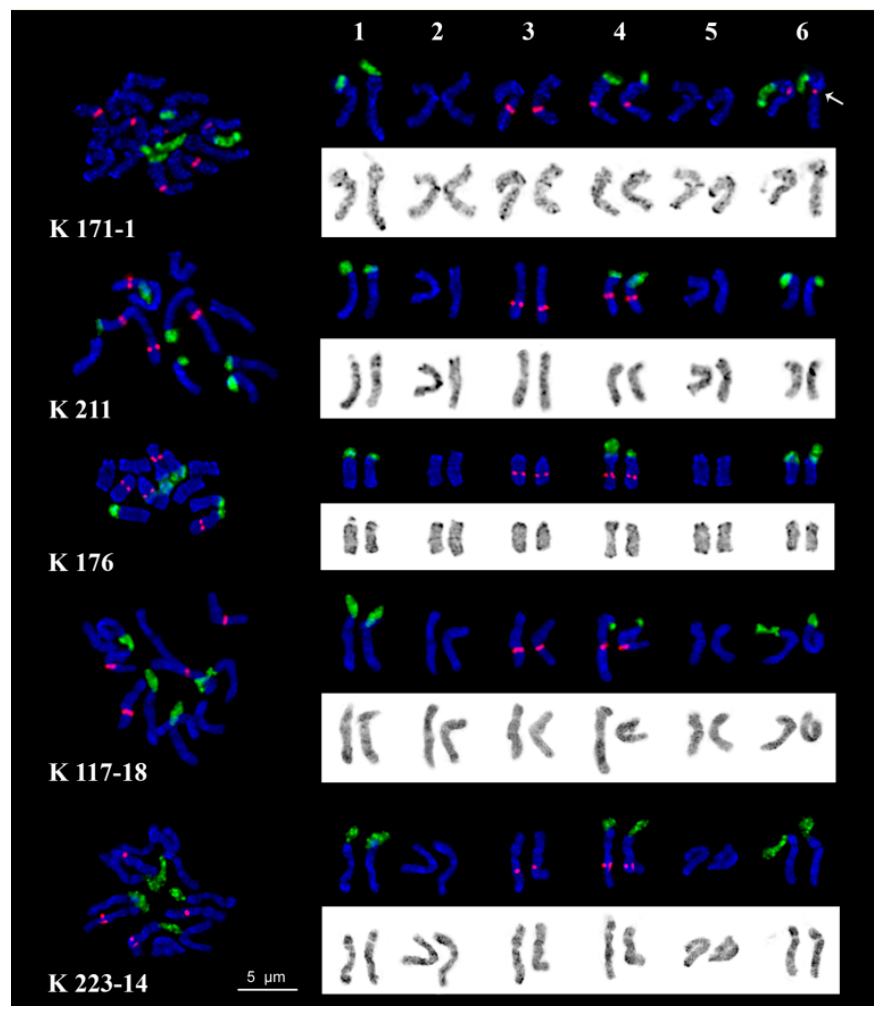
Figure 5. Karyotypes of the studied Chelidonium majus plants. Metaphase spreads and karyograms after FISH with 45S (green) and 5S (red) rDNA. DAPI banding patterns are shown as inverted images. Arrow points to the minor polymorphic 5S rDNA loci. Scale bar = 5 µm.